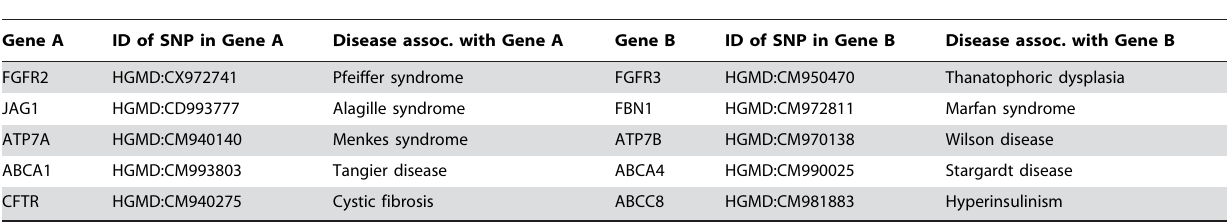
Table 3. Selected Class 1 SNP